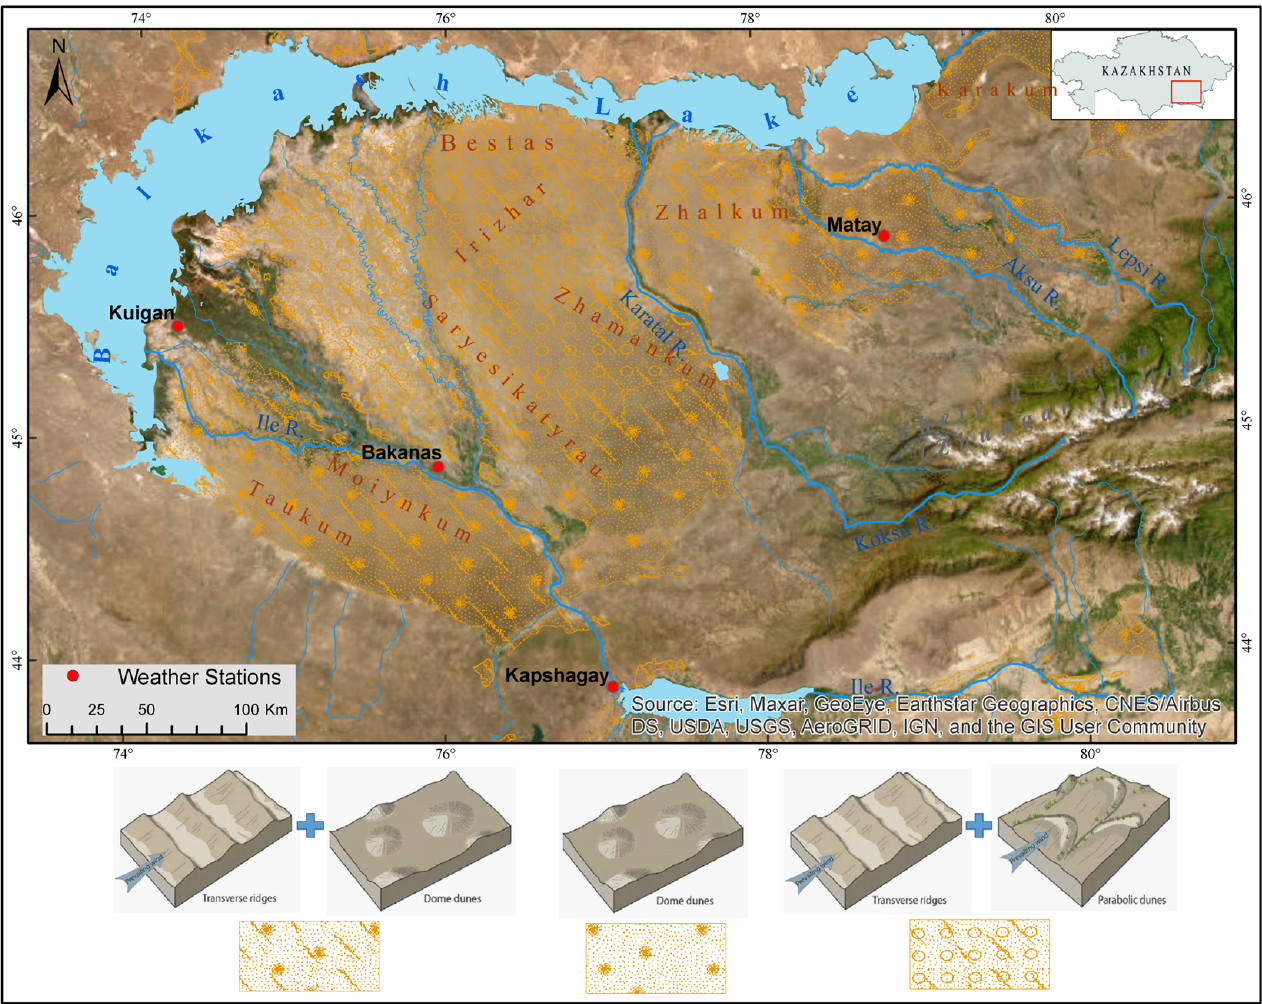
Figure 1. Desert sands and their geomorphological types in the Southern Balkash deserts. The climate of the deserts is continental and arid [48]. The Southern Balkash is de- scribed by large daily and annual fluctuations in air temperature and has a high solar radiation level and a long dry summer period. The air temperature in January is an average of − 16 ◦ C in the northern part, the southern part of the plain territory is − 5 ◦ C , and